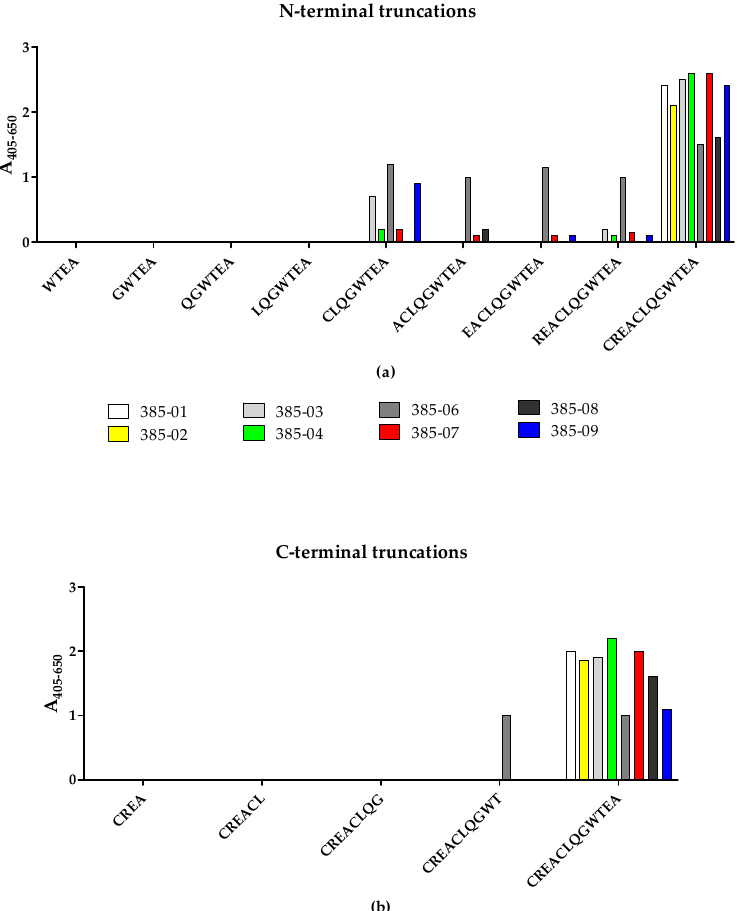
Figure 5. Reactivity of SSI-HYB clones to N- and C-terminally truncated frameshifted calreticulin peptides by modified enzyme-linked immunosorbent assay: ( a ) Reactivity of clones to N-terminally truncated resin-bound peptides. ( b ) Reactivity of clones to C-terminally truncated resin-bound peptides. Absorbances were corrected for background reactivity by subtracting reactivity from non-coated wells.